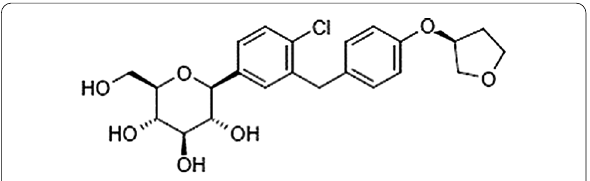
Fig. 1 Structure of empagliflozin